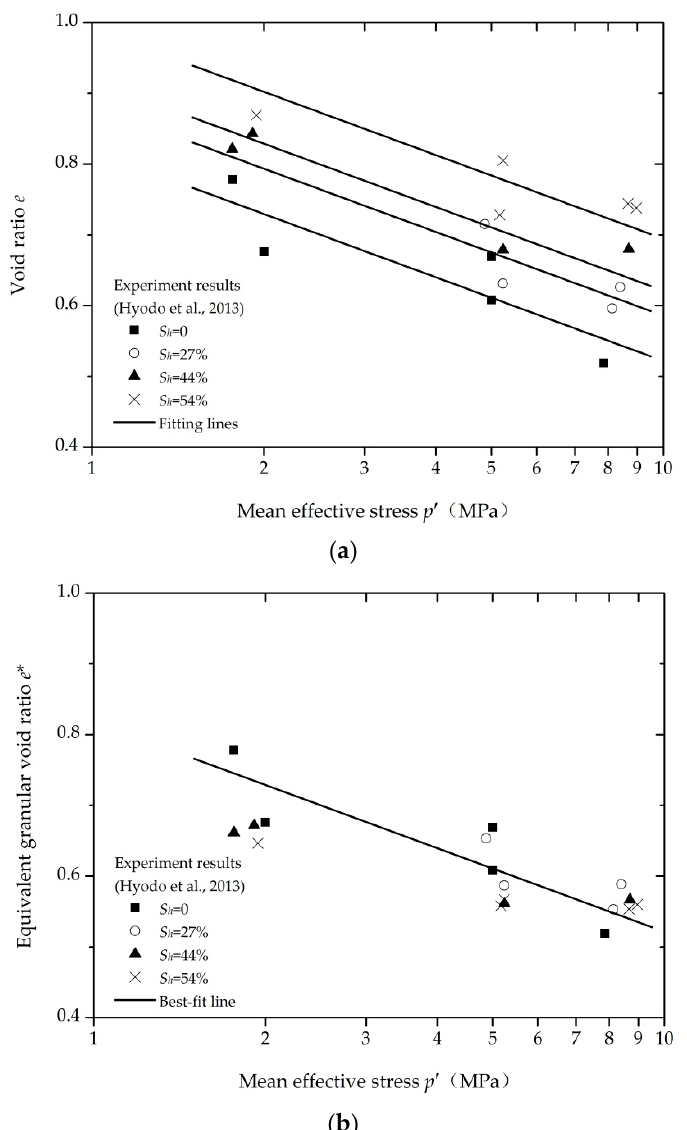
Figure 1. Critical state lines of methane hydrate-bearing sand (MHBS) synthesized from Toyoura sand in the ( a ) e –ln p’ plane; ( b ) e* –ln p’ plane.